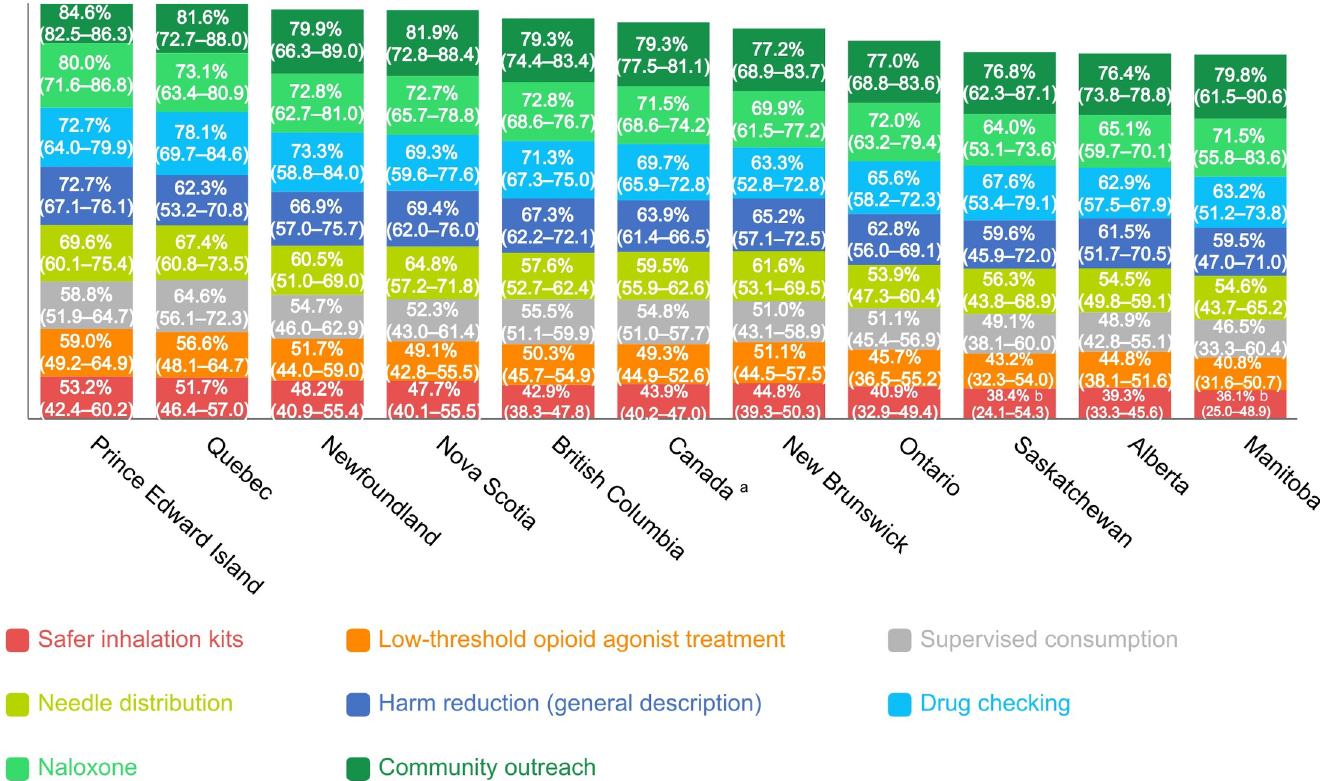
Fig 2. Proportion of Canadians supporting or strongly supporting harm reduction, 2018. a Canadian estimates calculated on the nationally representative subsample ( n = 2002). b Moderate sampling variability ( > 16.6%), interpret with caution.